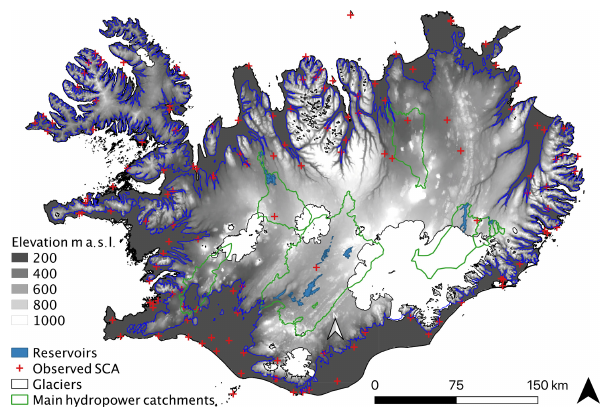
Figure 1. Overview of Iceland. Red outlines show the main catch- ment boundaries for large hydropower diversions, reservoirs and power plants. Manned sites for observed snow cover are shown in green points. Contours are shown for the 200m elevation band. A solid blue contour represents 200m elevation.